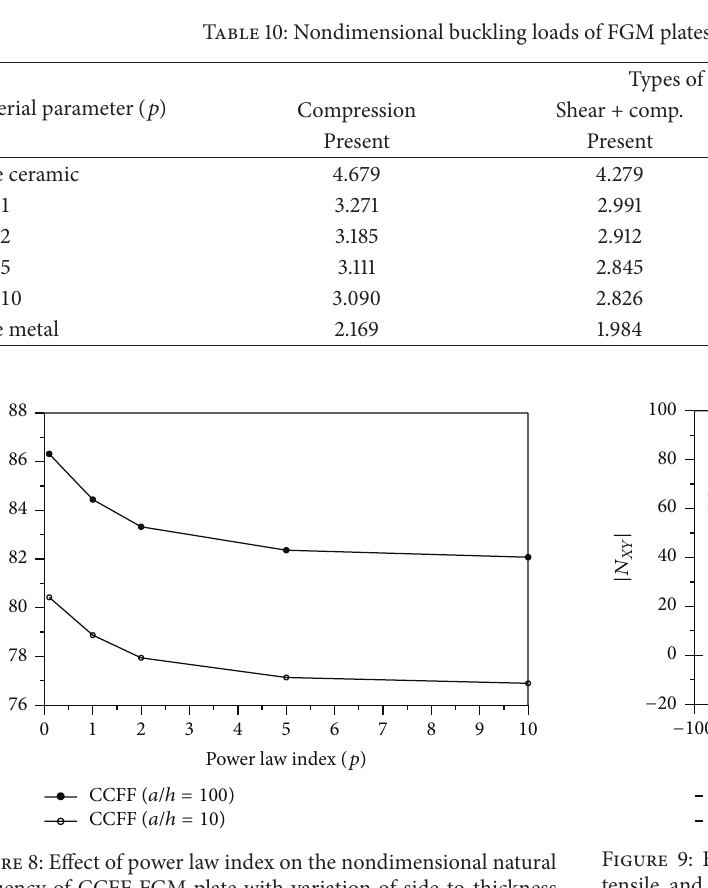
Table 9: Nondimensional buckling loads of FGM plates (𝑁